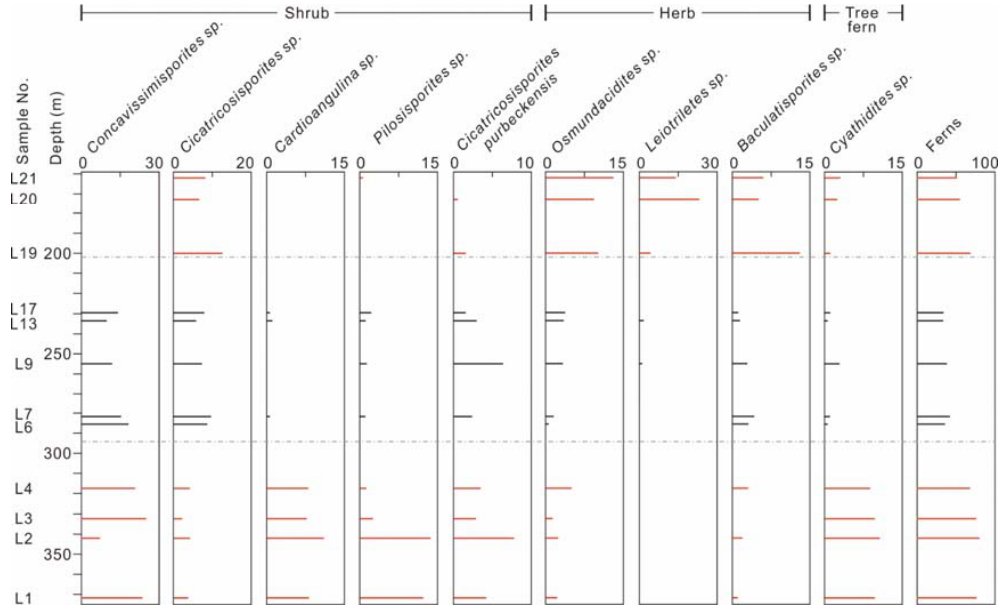
Figure 7. Percentages of major spores in oil shale and coal. The red bar represents oil shale, and the black bar represents coal. The two horizontal grey lines show the boundaries of the three units.